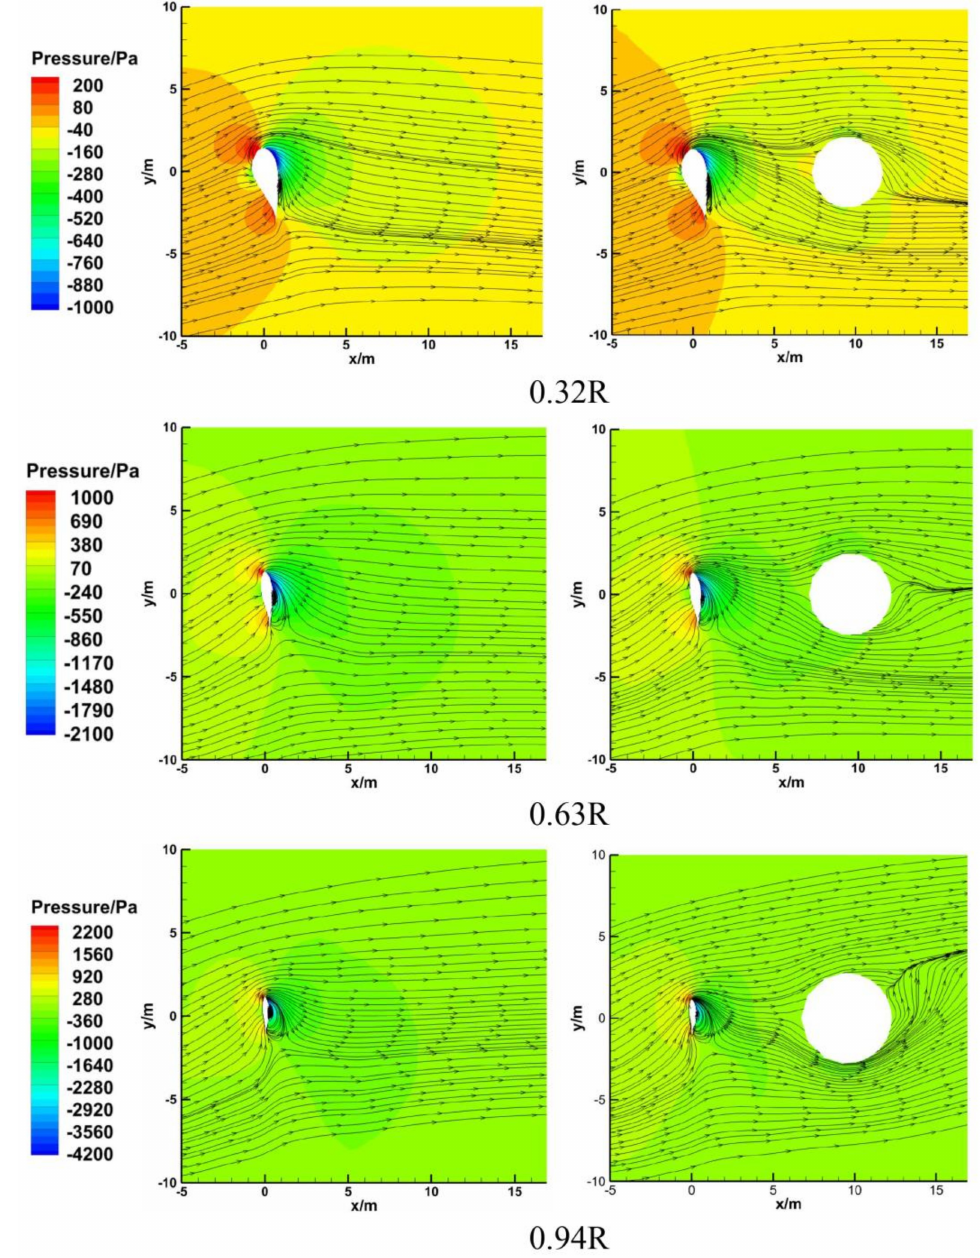
Figure 23. Streamline and pressure contours on different blade sections under yaw